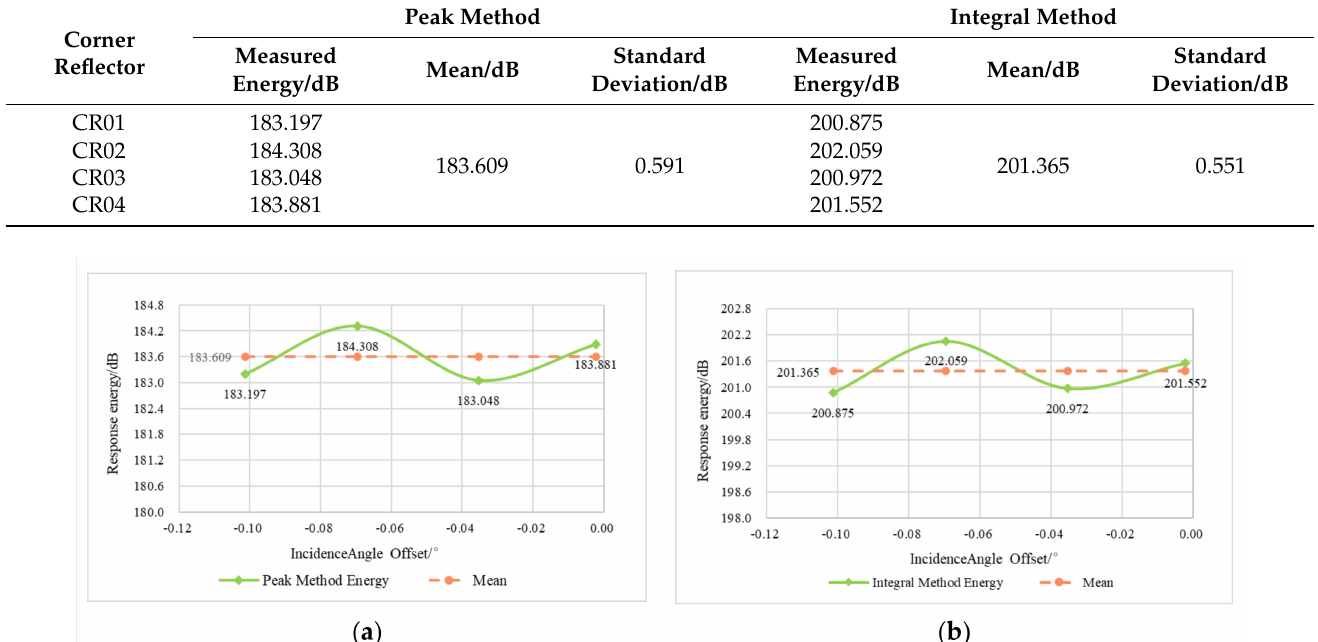
Table 4. Validation and analysis of the relative correction of the point target response energy.